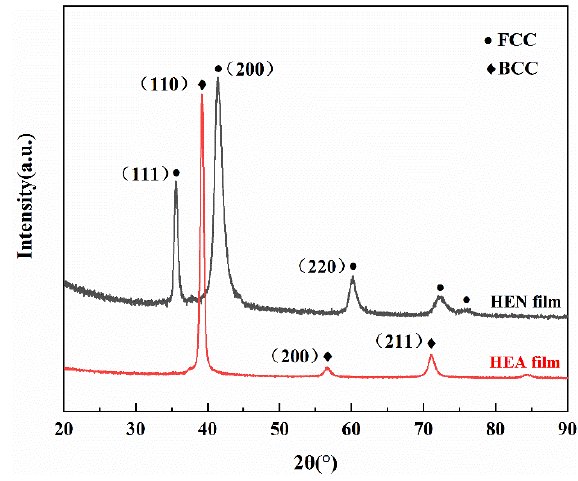
Figure 2. The XRD spectrum of TiAlMoNbW HEA and HEN films.